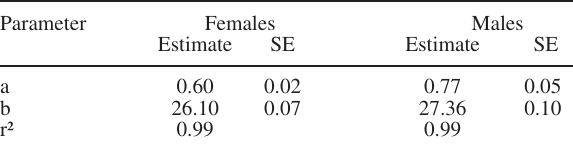
Table 1. – Estimates of parameters of logistic equation for females and males of Buenia affinis from the Kvarner area (r² coefficient of determination, SE standard error). b = length at sexual maturity (L 50